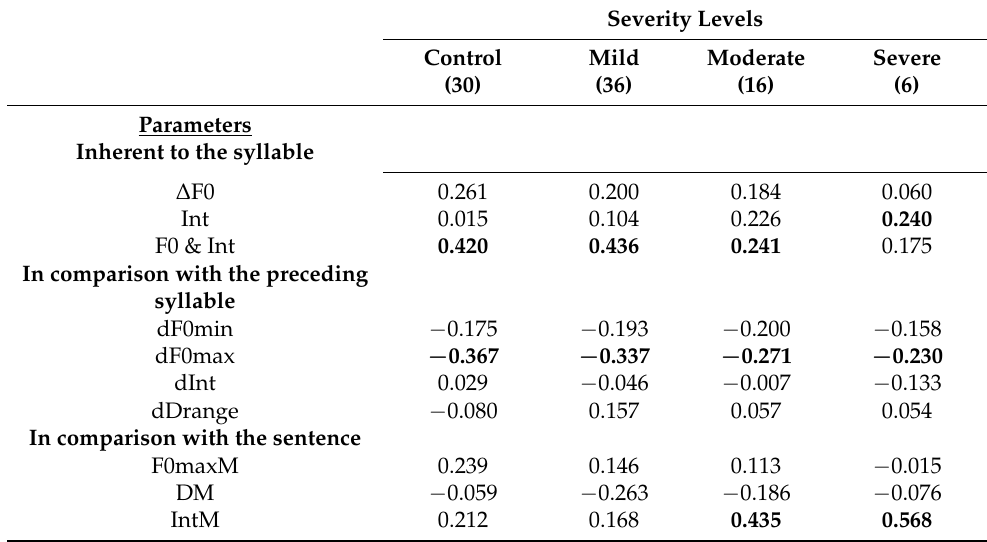
Table 9. Standardised canonical discriminant function coefficients per group of dysarthria severity levels (mixed groups of English and Dutch